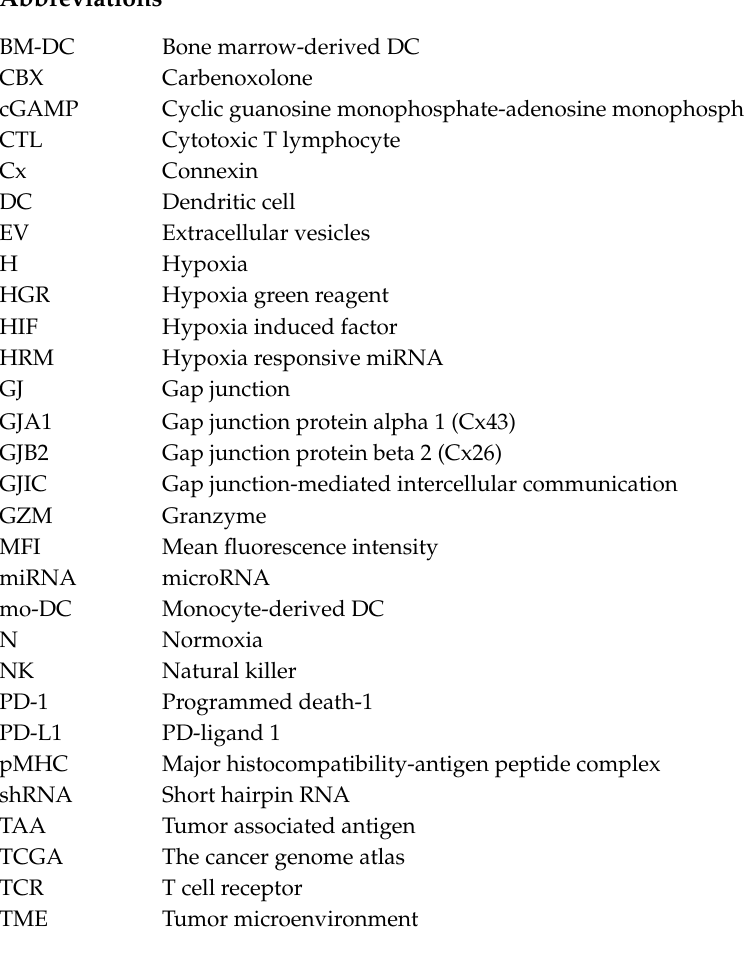
Figure S1: Cx43 expression and gap junction intercellular communication in stably transfected cells, Figure S2: Human monocyte-derived dendritic cells acquire miR-210-3p and miR-449a from hypoxic Mel3 melanoma cells, Figure S3: Correlations of ZEB2 and granzymes mRNA expression in cancer patients, Figure S4: Main antitumor roles of Cx43-GJICs in the cancer-immunity cycle, Figure S5: Proposed model for Cx43-dependent suppression of cytotoxic activity of cytotoxic T lymphocytes by hypoxic melanoma cells, Figure S6: Cytotoxic T